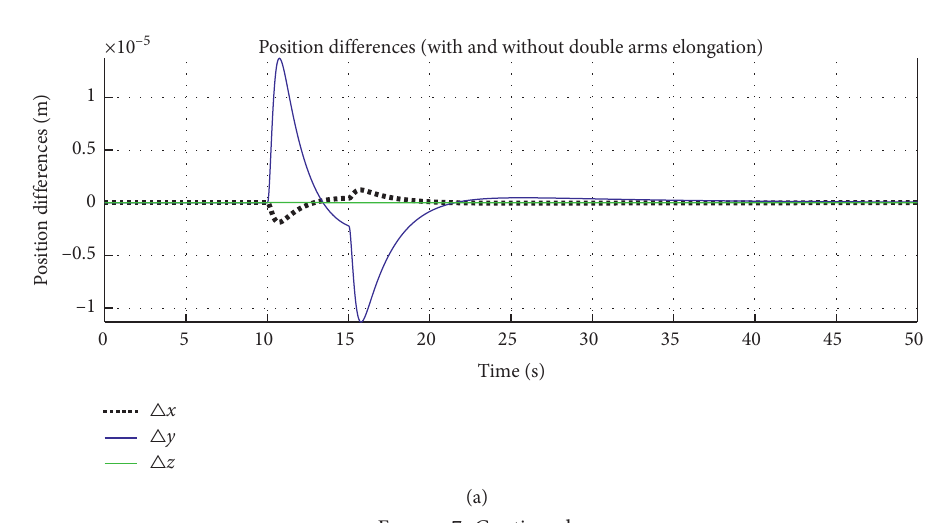
Figure 6: Curve of single-arm folding.